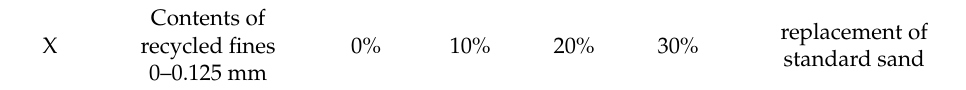
Table 5. The percent content of recycled fines as sand replacement.